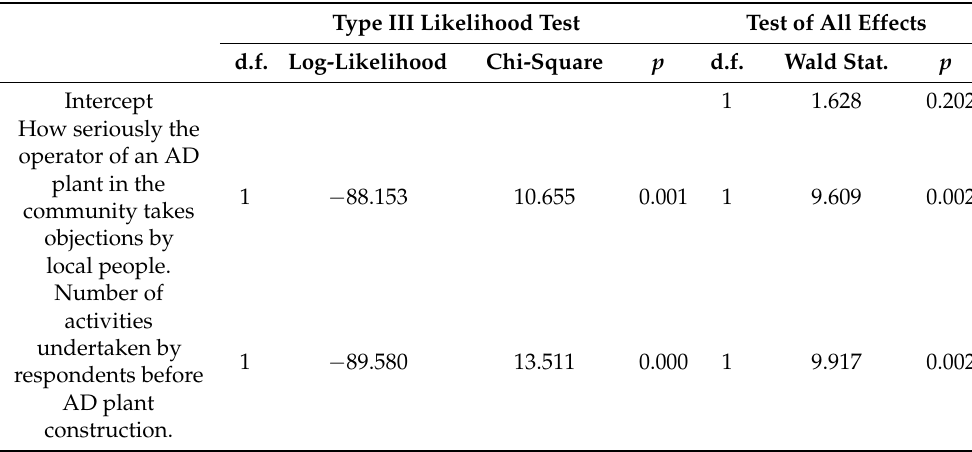
Table 3. Results of binomial logit regression model (Hosmer Lemeshow = 6.480, p = 0.100; Nagelkerke pseudo R 2 = 0.217).